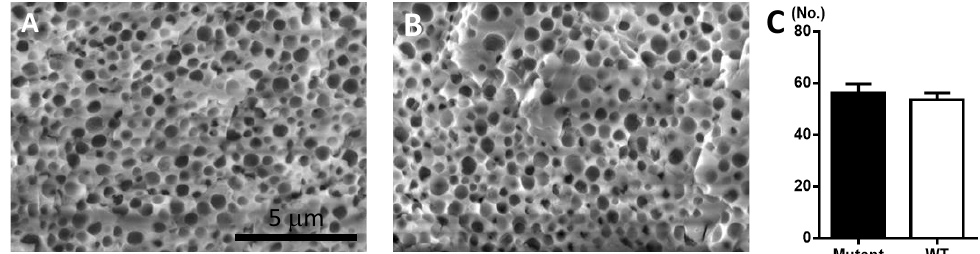
Figure 2. Cross-section of palisade layer in quail egg. ( A ) SEM image of the palisade layer in MSTN mutant egg. ( B ) SEM image of the palisade layer in WT egg. ( C ) Comparison of the number (No.) of vesicular holes in a square area of 5 μm × 5 μm within the palisade layer.